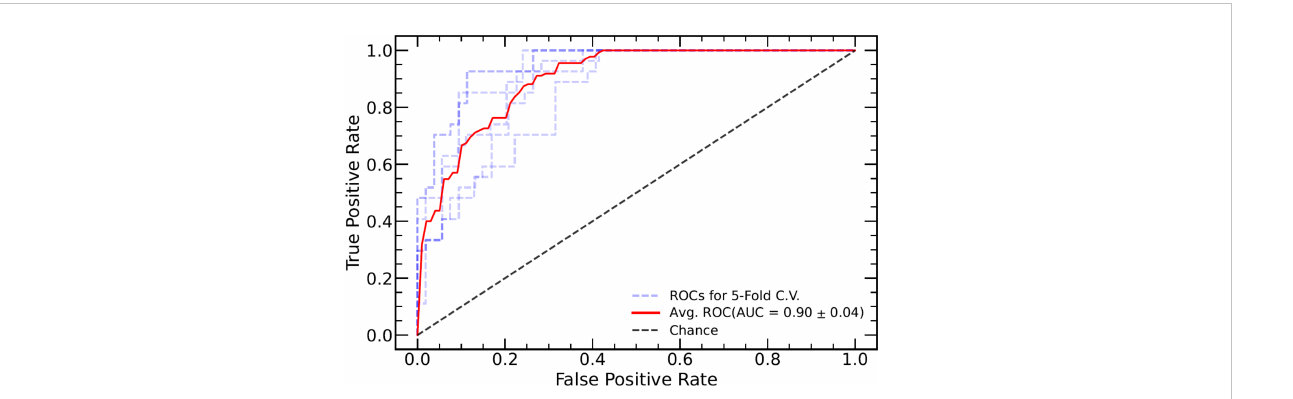
FIGURE 3 ROC curve of the combined model of DWI and clinical factors. The blue dotted lines represent the ROC curve of fi ve-fold cross-validation (CV), and the red line represents the mean ROC curve of the fi ve-fold CV. ROC, receiver operating characteristic; DWI, diffusion-weighted